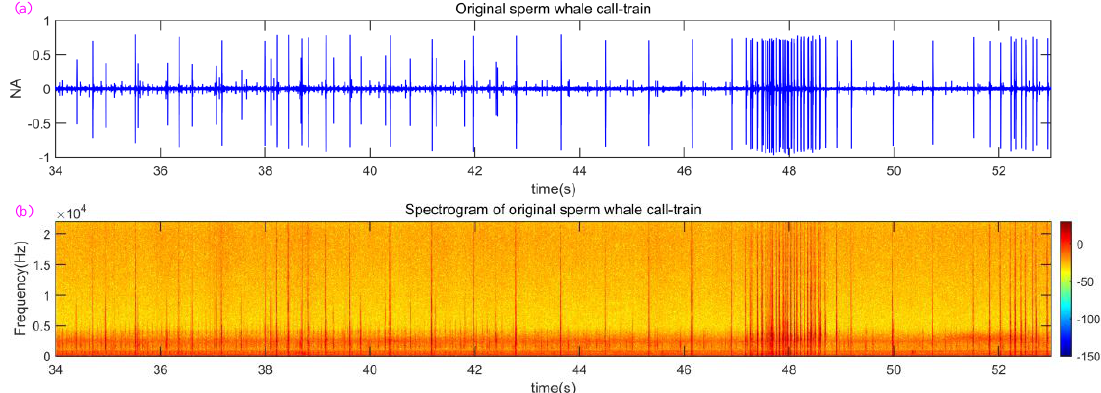
Figure 2. Waveform and spectrogram of original sperm whale call-train from the 34th to the 53rd s. ( a ) Original sperm whale call-train; ( b ) spectrogram of original sperm whale call-train.